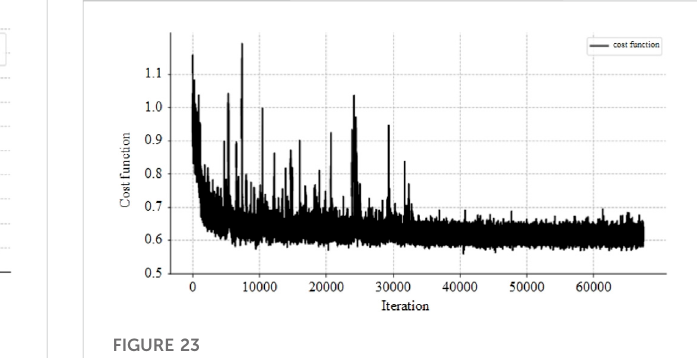
FIGURE 20 Accuracy of CNN-dropout network.